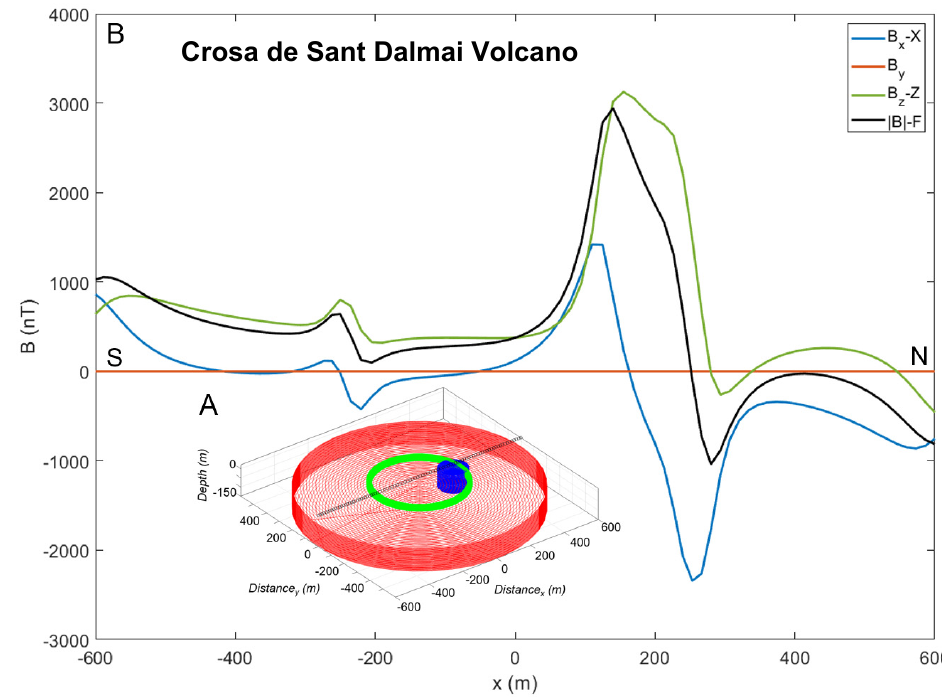
Figure 10. ( A ) Scheme of the simulated structure: the elements in red and green simulate the old crater and its deposits with a susceptibility of χ = 10 − 2 SI and a natural remanent magnetization of (Mx, My, Mz) = (2, 0, 3) Am − 1 ; 2, and the blue cylinder depicts the material in the vent of the last eruptive episode with a susceptibility of χ = 10 − 2 SI and a natural remanent magnetization of (Mx, My, Mz) = (4, 0, 6) Am − 1 . ( B ) Graph of the magnetic field components and intensity calculated as |B|-F, sourced by the model.